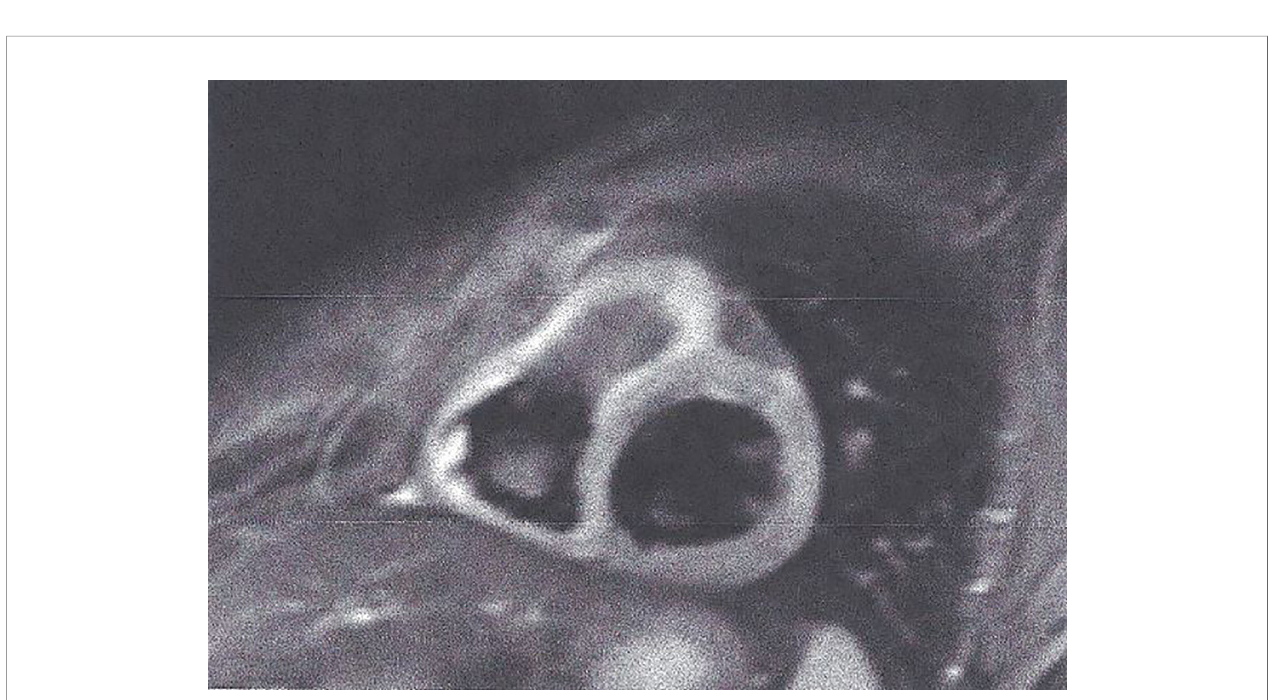
FIGURE 3 | STIR T2 image showing subepicardial oedema in myocarditis. This fi gure is original and based on data from Mavrogeni et al.